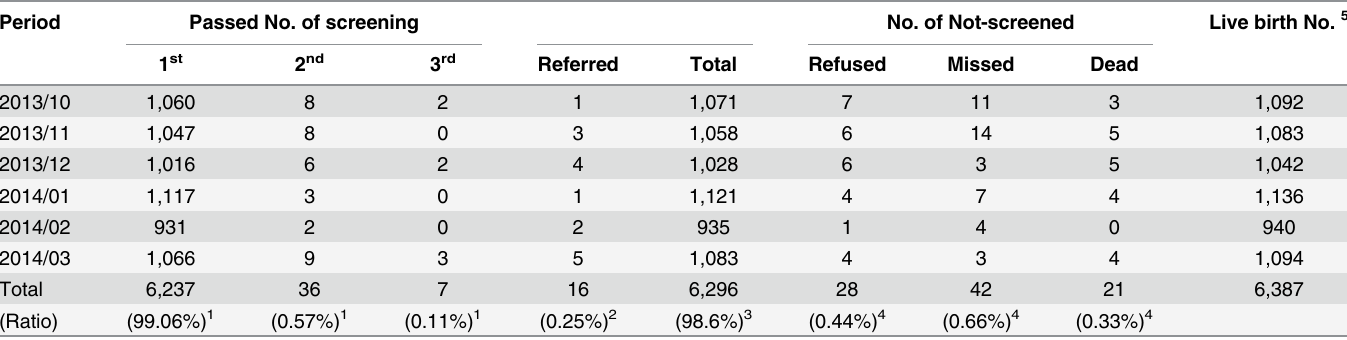
Table 1. Results of CCHD screening program in Taipei.